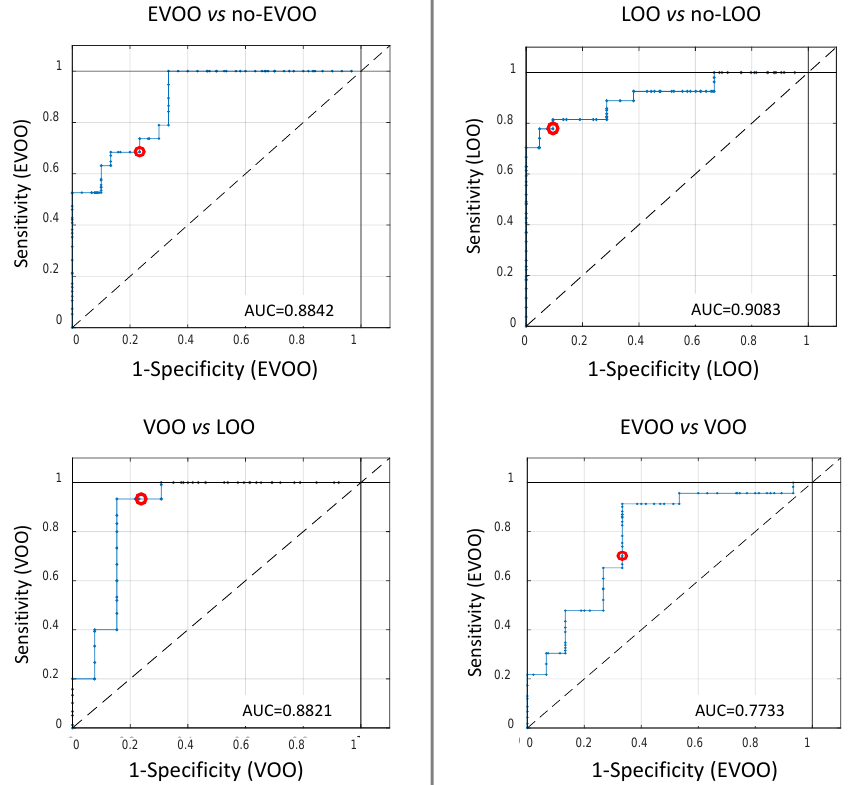
Figure 4. Receiver operating characteristic (ROC) curves of PLS-DA models used to discriminate samples according to quality grade. The red circle identifies selected sensitivity and 1-specificity values for the prediction model.